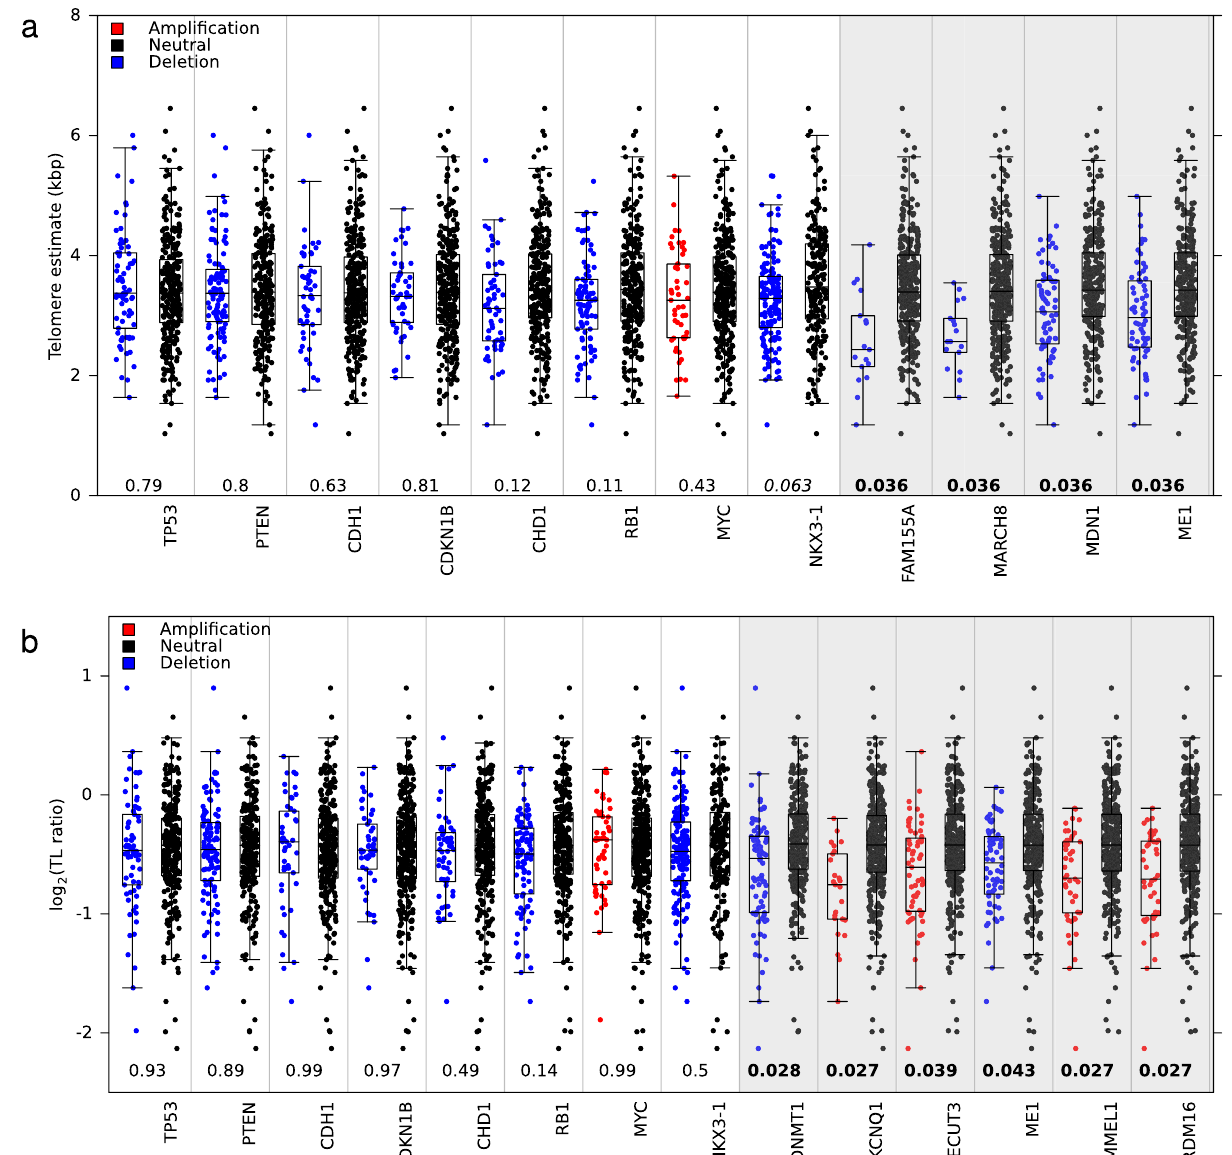
Fig. 5 Telomere length differs by copy number status. a , b Difference in a tumour TL and b TL ratio between samples ( n = 381) with a copy number aberration and those without in prostate cancer-related genes and associated genes. Q values are from a two-sided Mann – Whitney U test and are bolded when signi fi cant (FDR < 0.05). Box plots depict the upper and lower quartiles, with the median shown as a solid line; whiskers indicate 1.5 times the interquartile range